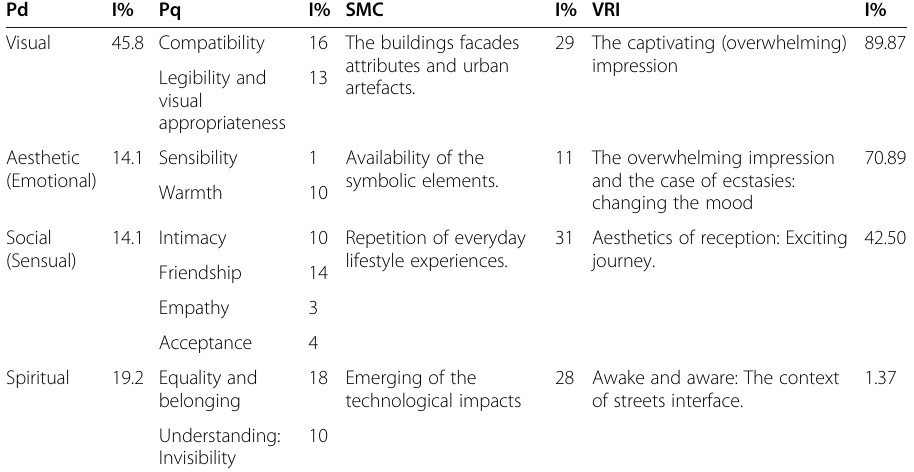
Table 2 The degree of importance (I) of Pd, SMC and VRI Pd I% Visual 45.8